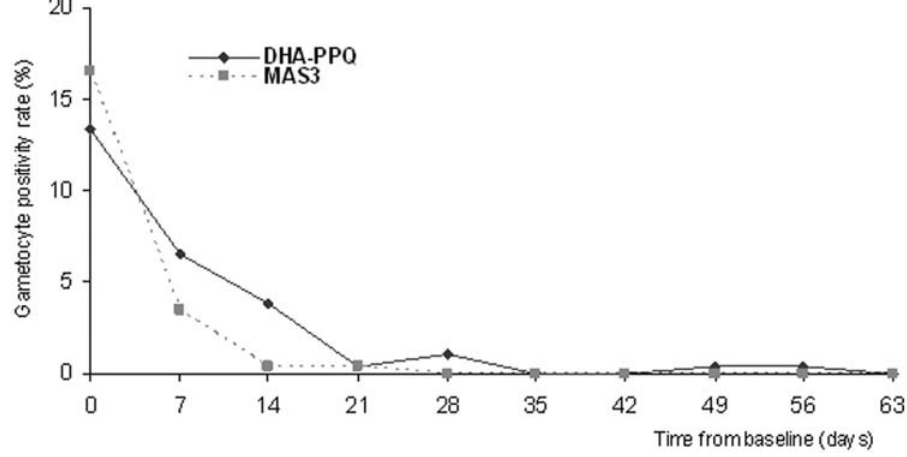
Figure 2. Proportions of patients with gametocytemia during the follow up. doi:10.1371/journal.pone.0001101.g002 PLoS ONE |